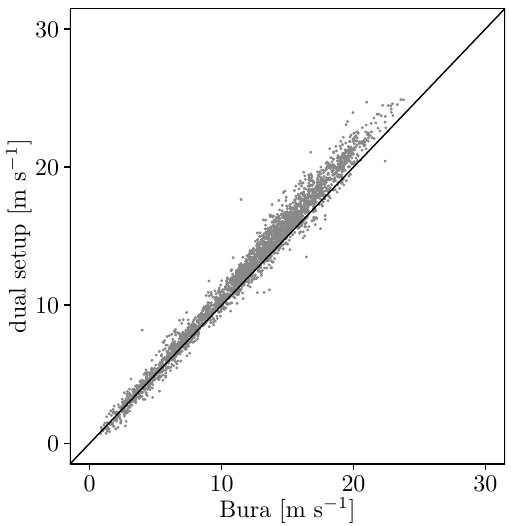
Figure 9. Scatter plot of the 10 min mean wind speeds for Bura and those reconstructed by the dual setup (for the position x = 447,052 m) at 100 m ASL. A line through the origin with a slope of 1 is ≈ shown in